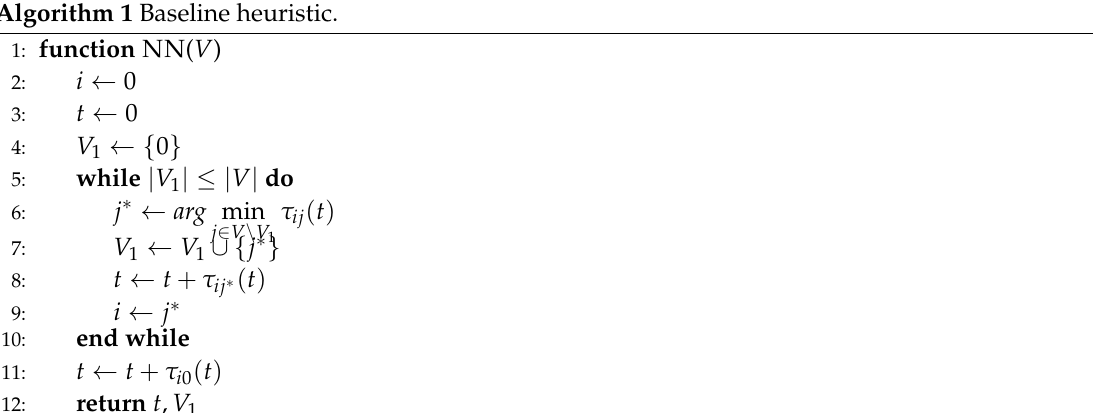
Algorithm 1 Baseline